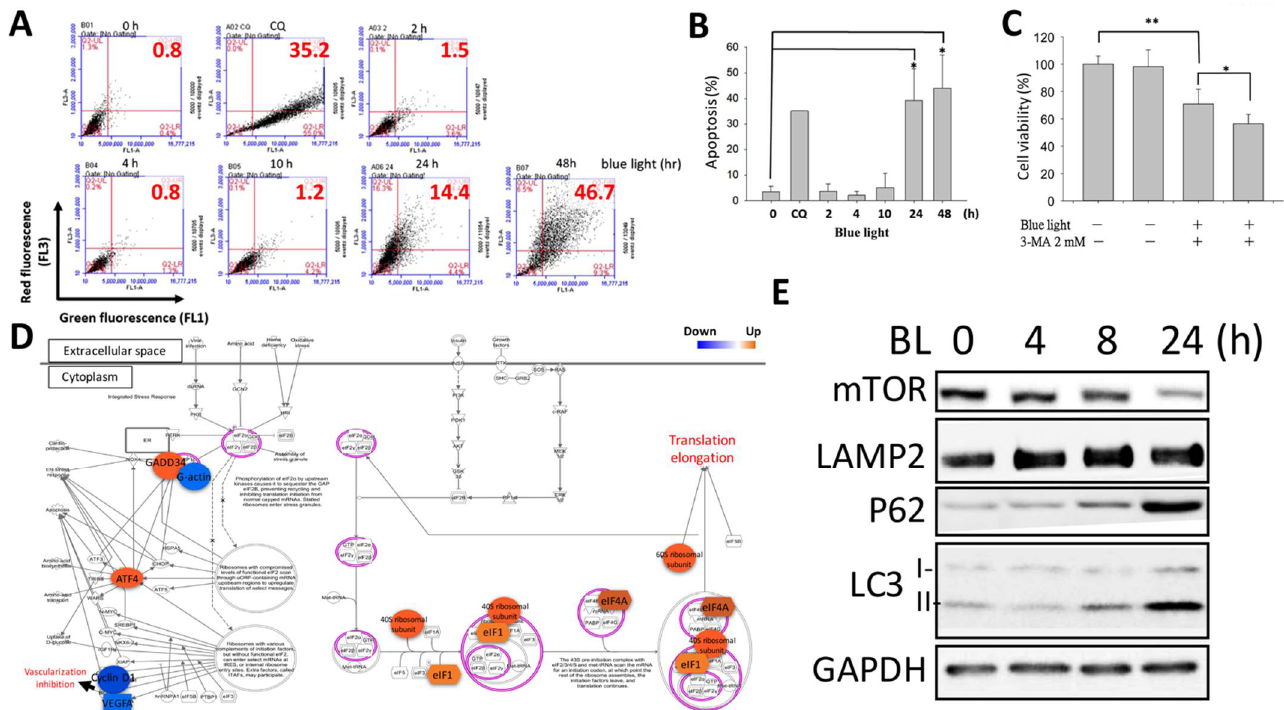
Figure 4. Blue-light-activated ARPE-19 autophagy. ( A ) Flow cytometry was used to determine the autophagic effect induced in ARPE-19 cells by blue light exposure using acridine orange staining. Chloroquine (CQ) was used as a positive control to activate autophagy. ( B ) Quantitative results of blue-light-activated ARPE-19 cell autophagy from 0 to 48 h (* p < 0.05). ( C ) To determine the role of the autophagy effect in blue-light-induced ARPE-19 cell death, the autophagy up-stream regulator PI3K inhibitor 3-MA was used to demonstrate cell viability. An MTS (2 mM) assay was used for the cell viability determination (* p < 0.05, ** p < 0.01). ( D ) RNA-Seq and IPA revealed the underlying mechanism regulated by blue light in ARPE-19 cells. Blue: decreased gene expression; orange: increased gene expression. ( E ) Western blot analysis of the expression of autophagy-related regulator markers, including the initiator inhibitor mTOR, lysosome regulator LAMP2, and autophagosome P62 and LC3 I/II. ARPE-19 cells were exposed to blue light for up to 24 h.